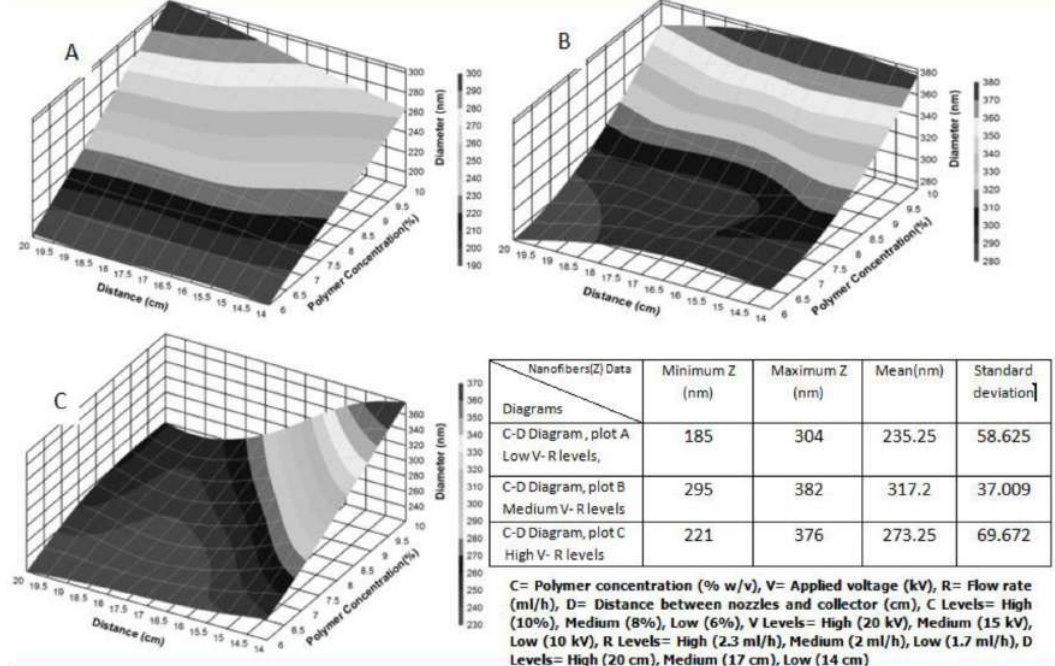
Fig. 5. The data and 3 D plots of nanofibers diameter predicted by ANN fixed in mentioned levels (C-D